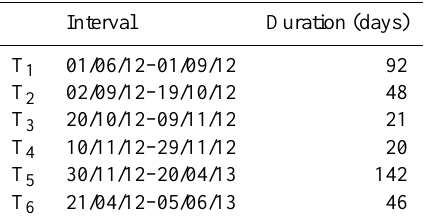
Table 2. Definition of time intervals T 1 –T 6 . Dates are given in the format